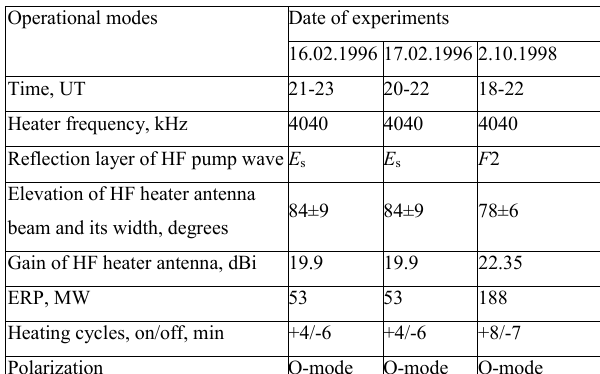
Table 1. Operational modes of the EISCAT HF heating facility during experiments